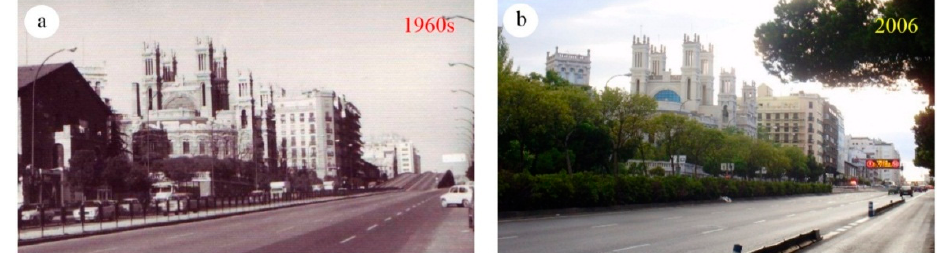
Figure 2. ( a ) Flyover on the street with heavy traffic in the 1960s (courtesy of Fernando de Castro López-Villarino); and ( b ) eastern entrance to the underpass in 2006.